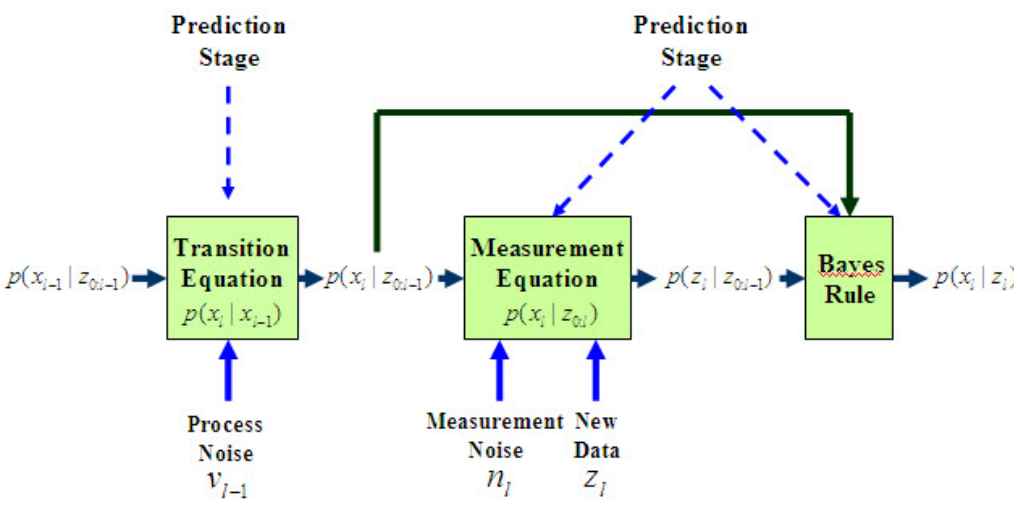
Figure 7. The recursive computation of the filtering